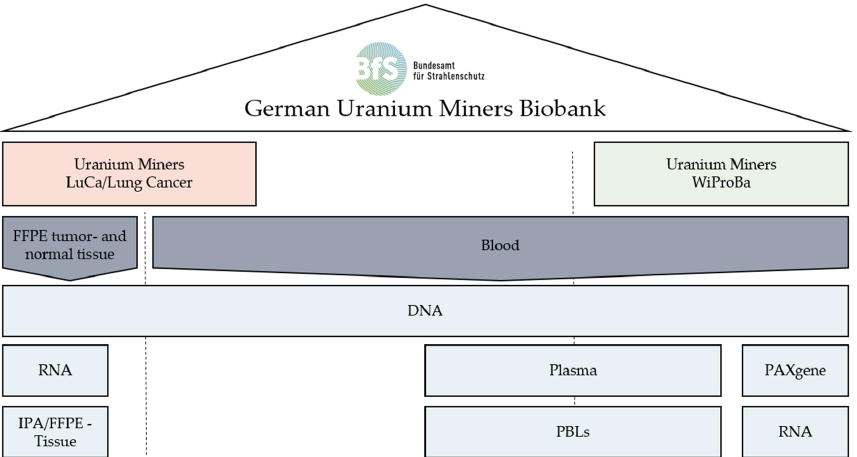
Figure 6. Lanes 1–18: Representative examples of DNA samples isolated from FFPE material. Lane M: λ x HindIII marker. DNA is stored in LuCa. Although the isolated DNA is highly fragmented, it was shown to be suitable for PCR amplification of short fragments (<500 bp).